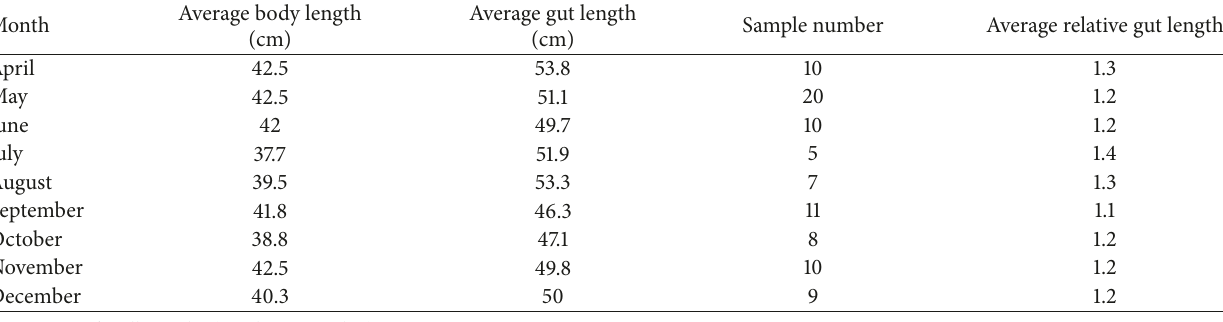
Average RGL for all samples (April to December) = 1.2 ± 0.085.